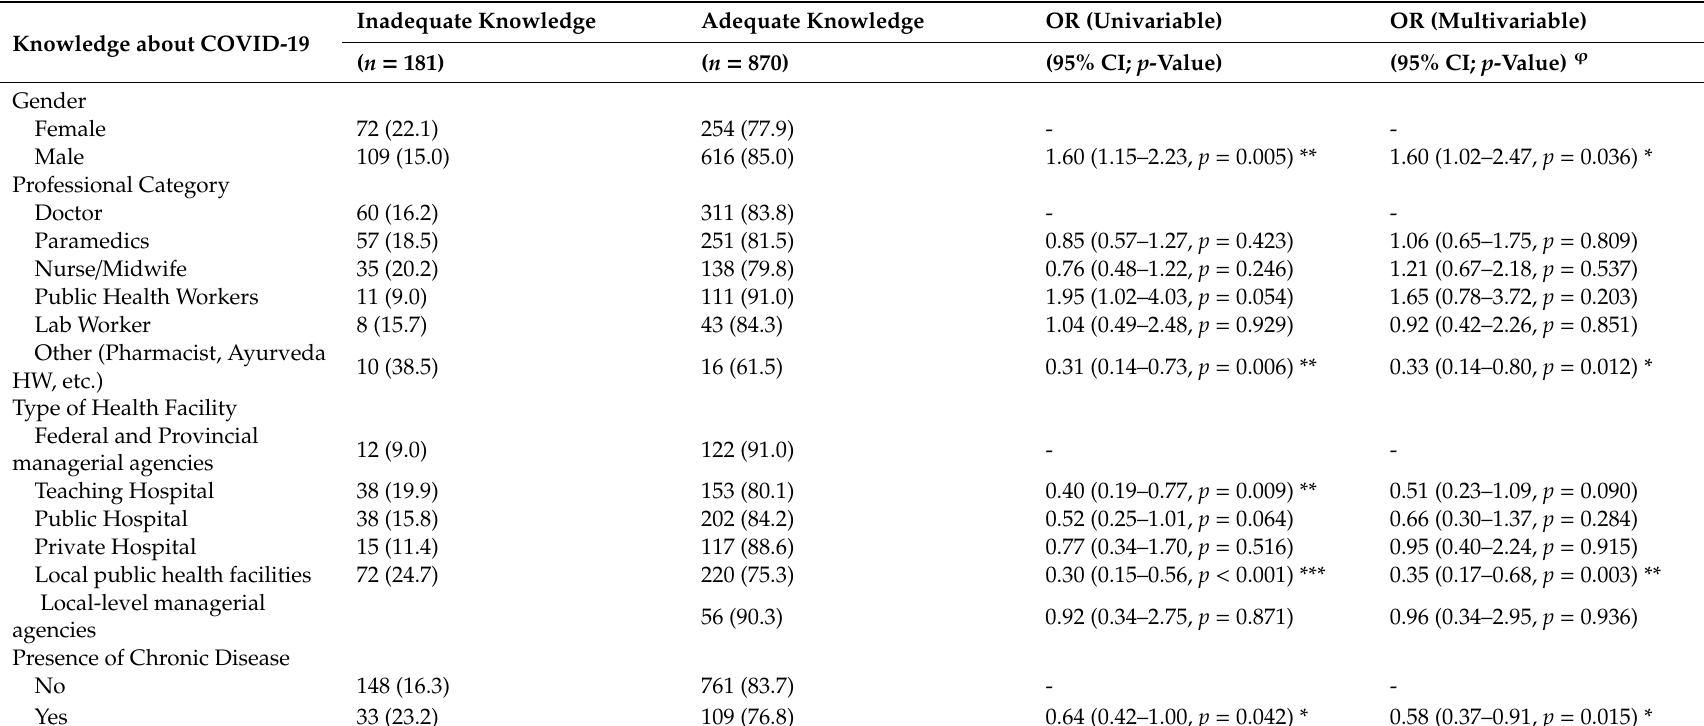
Table 2. Factors associated with knowledge of